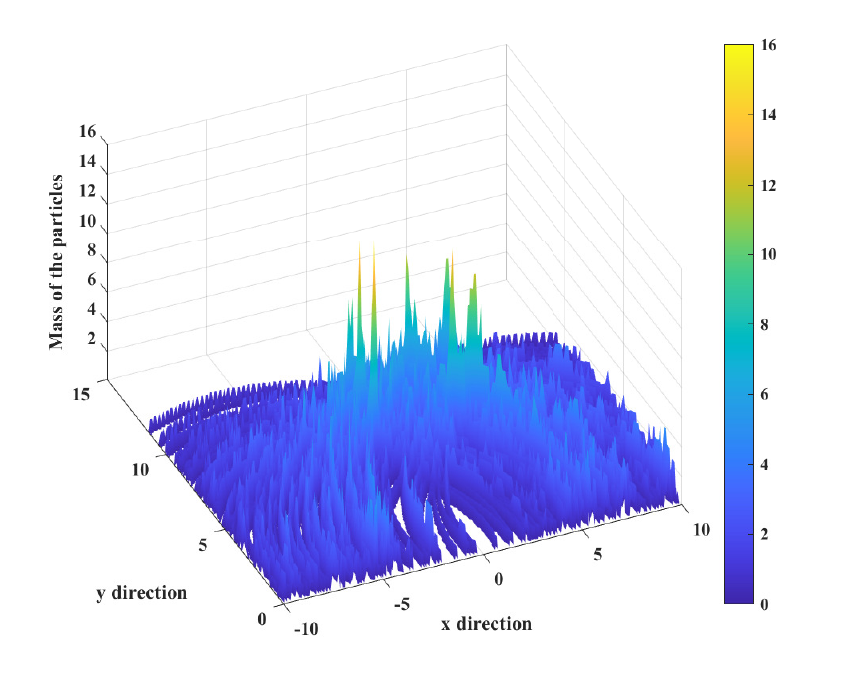
Figure 5. Plot of particle weightings for the 2-D grid, derived from the ellipses in Figure